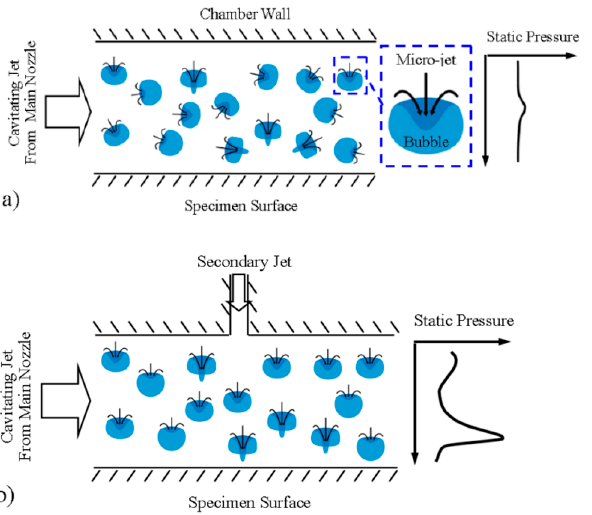
Figure 8. Illustration of cavitation ( a ) without and ( b ) with potential realignment using a second ‐ ary jet.